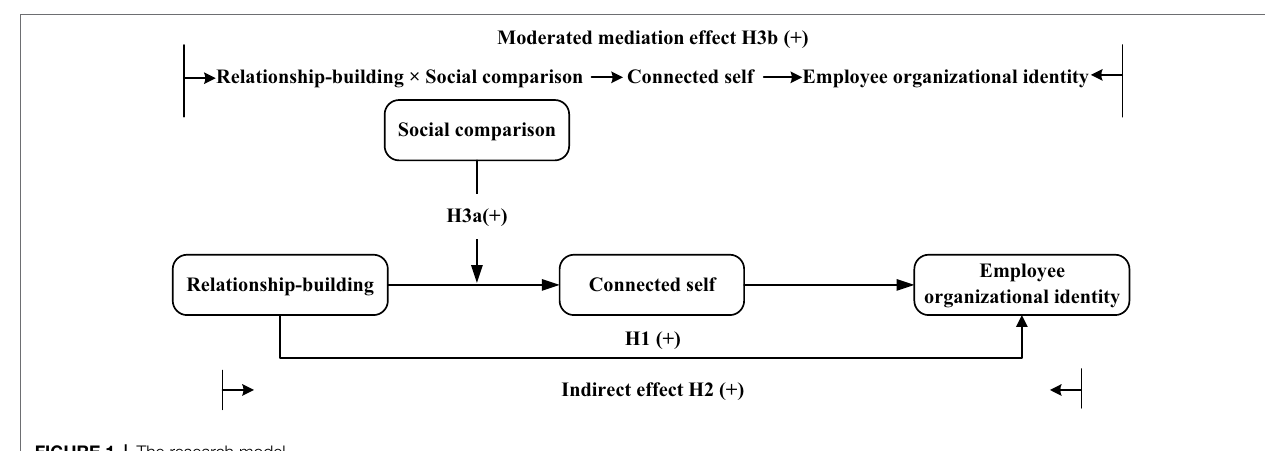
FIGURE 1 | The research